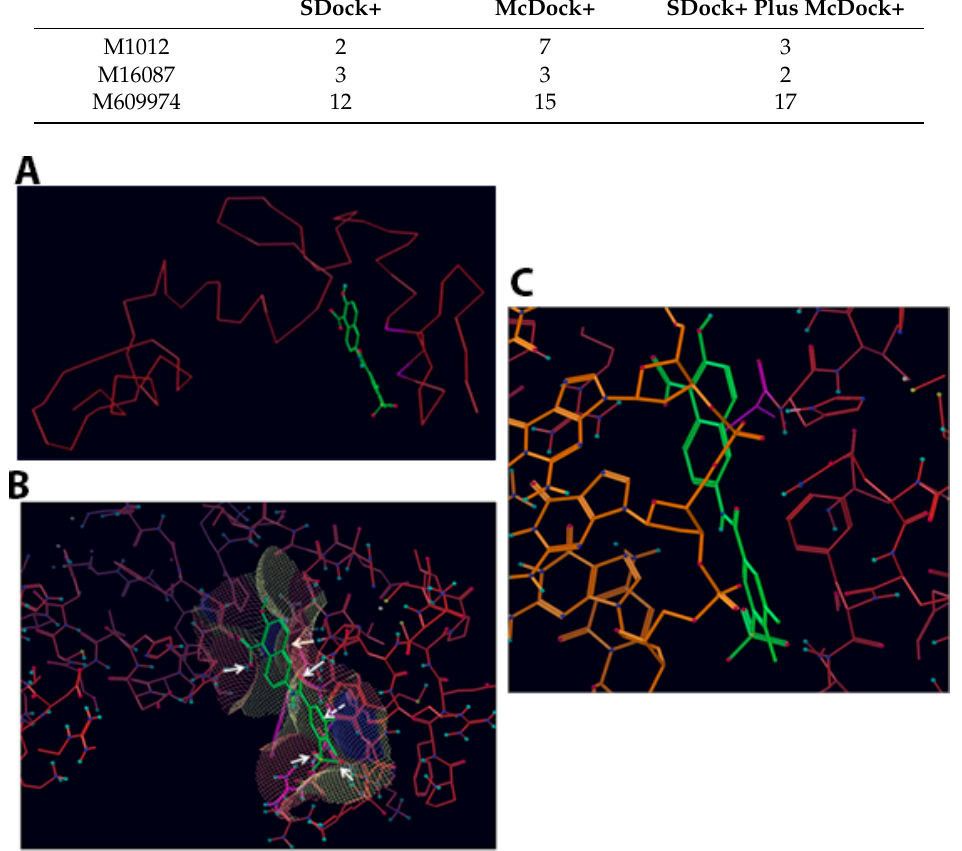
Figure 3. Compound T4 docked into Vezf1 Model binding site. ( A ) Only the alpha carbon trace is shown to indicate how T4 fits between two fingers. ( B ) Compound T4 docked into binding site with the accessible surface mesh. Arrows show important interactions with solid arrows indicating hydrogen bonds and dotted lines show stacking interactions between the compounds phenyl and phenyl ring of PHE123. ( C ) Compound T4 (green carbon atoms) docked into binding site (red carbon atoms). The structure 1AAY of the zinc finger 268 with DNA has been superimposed. Only DNA (orange carbon atoms) is shown.